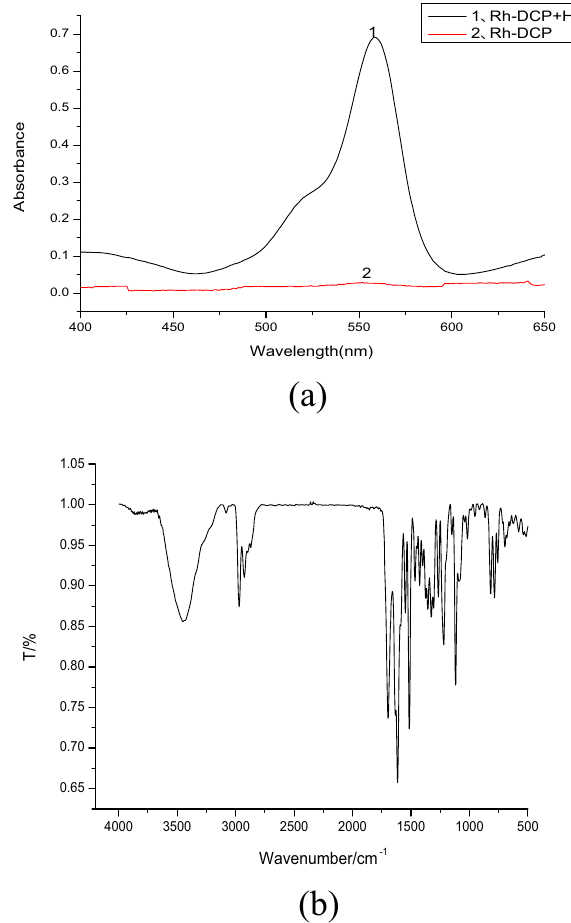
Figure 1: ( a ) UV - Vis absorption spectra of rhodamine class B deri - vatives and Hg 2 + fl uorescence systems ( CH 3 CH 2 OH/H 2 O [ v/v,1/2 ] , probe concentration 10 × 10 − 5 mol · L − 1 , Hg 2 + concentration 10 × 10 − 5 mol · L − 1 ) . ( b ) IR spectrum of Rh -